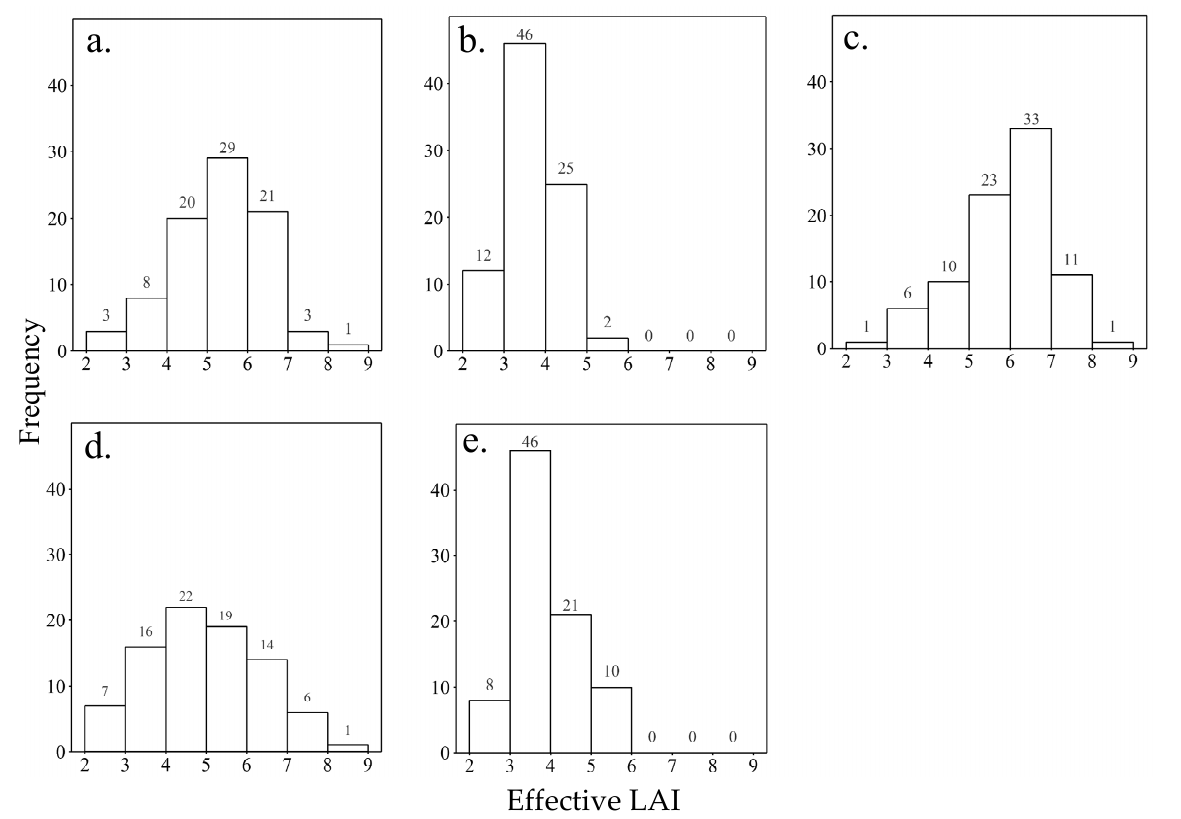
Figure 3. The distribution of effective LAI data estimated by different indirect methods. ( a ) LAI-2200; ( b ) DHP; ( c ) TRAC; ( d ) TLS1 (TLS multi-station); ( e ) TLS2 (TLS single-station).